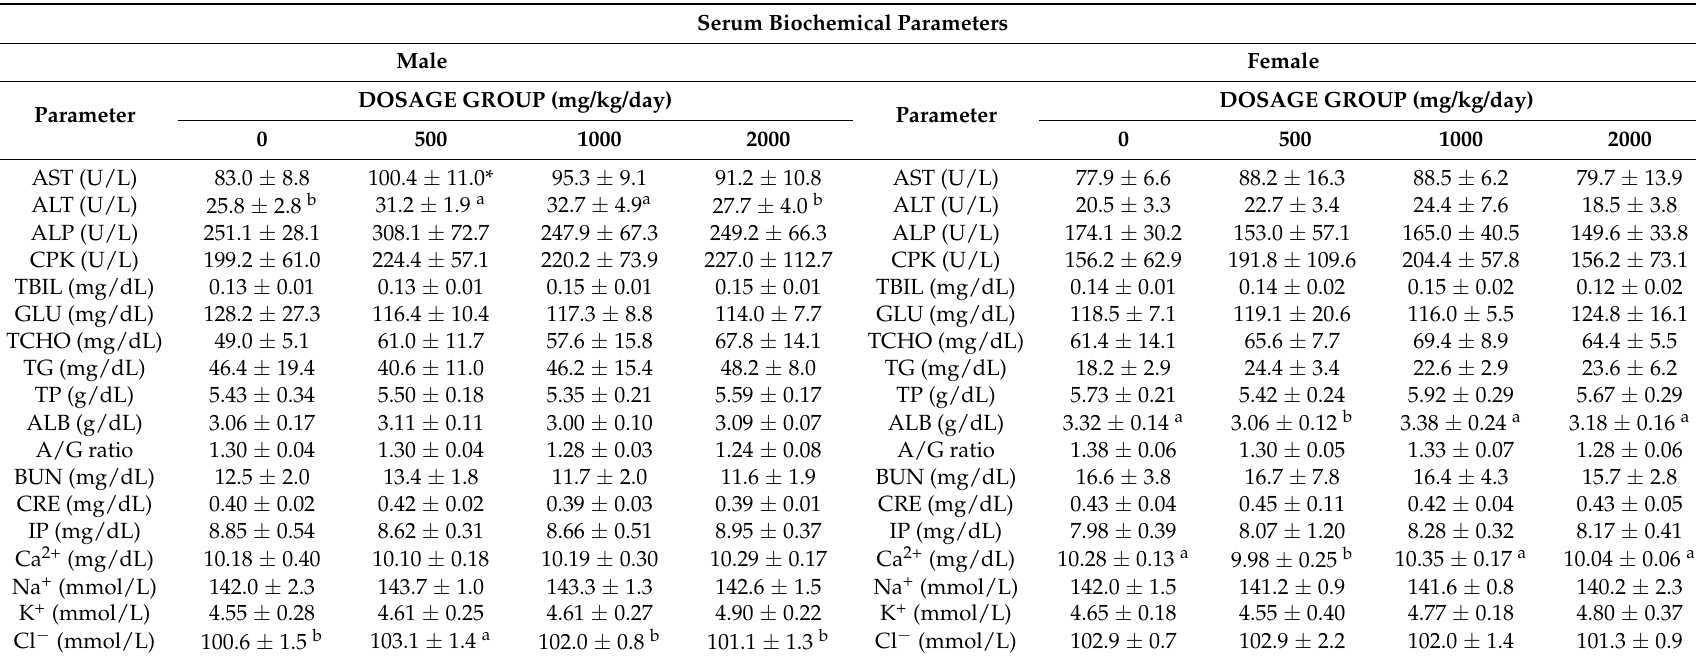
Table 3. Serum biochemical parameters in male and female rats given 500, 1000, or 2000 mg/kg/day GEE for 14 days in a repeated oral dose toxicity study. Serum Biochemical